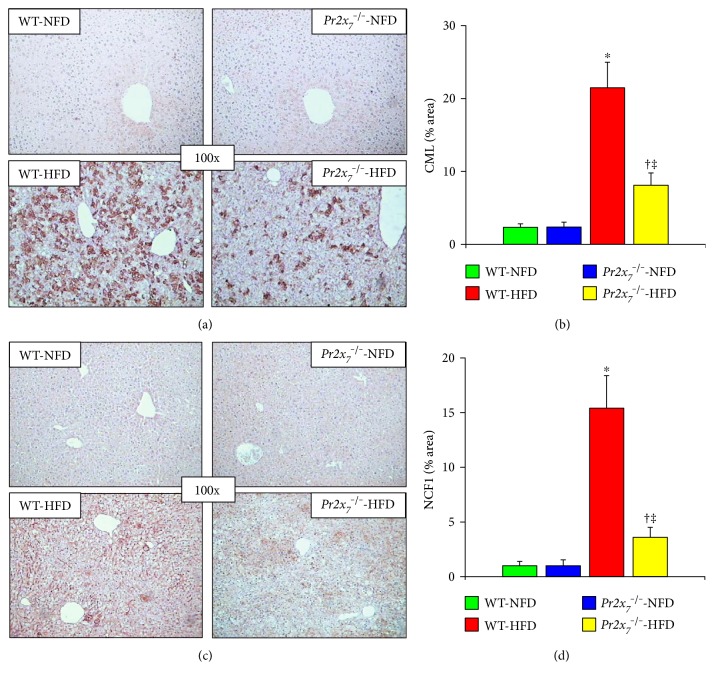
Oxidative and carbonyl stress markers. Immunohistochemistry for CML ((a); original magnification 100x) and NCF1 ((c); original magnification 100x) in liver sections from representative animals and quantification of liver CML (b) and NCF1 (d) protein content in HFD-fed WT and P2x7r−/− mice (mean ± SD; n = 4–6 per group). ∗P < 0.001 or †P < 0.05 versus the corresponding NFD-fed mice; ‡P < 0.001 versus WT mice. CML = Nε-(carboxymethyl)lysine; NCF1 = neutrophil cytosol factor 1; NFD = normal-fat diet; HFD = high-fat diet; WT = wild type; Pr2x7−/− = knockout for purinergic receptor 2X7 gene.